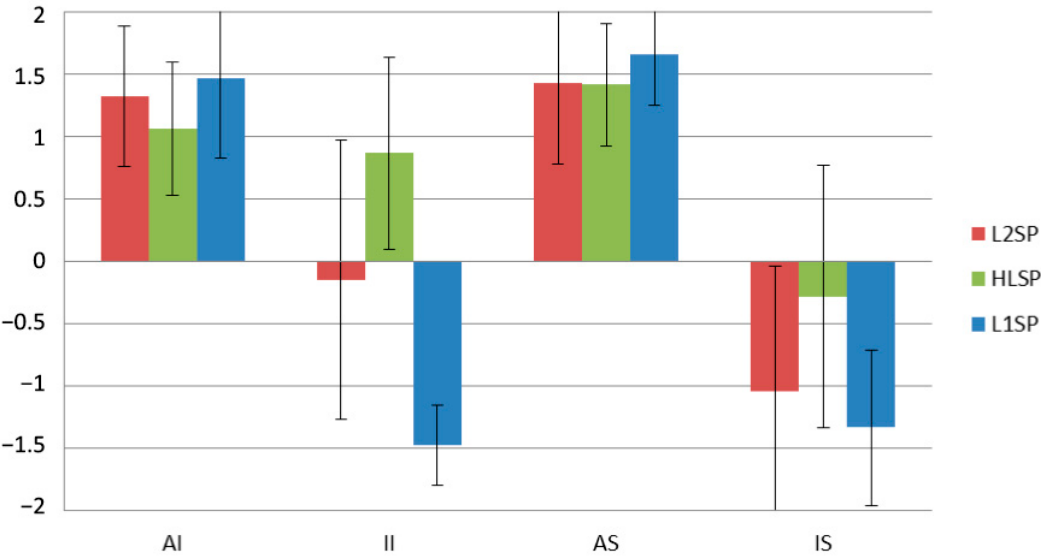
Figure 1. Overall results. Task 1—Sentence combination felicity task (written version). L2SP: L2